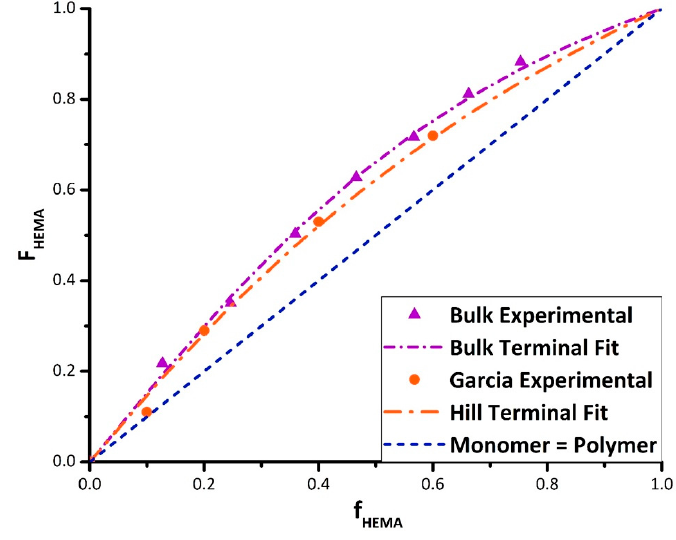
Figure 2. Mayo Lewis plot of HEMA molar composition in the copolymer (F HEMA ) vs. comonomer mixture (f HEMA ) for BMA/HEMA in bulk, compared with literature values reported by Fernández-García et al. [23] and Hill et al. [24]. Experimental data given by symbols, terminal model fits by dotted lines.